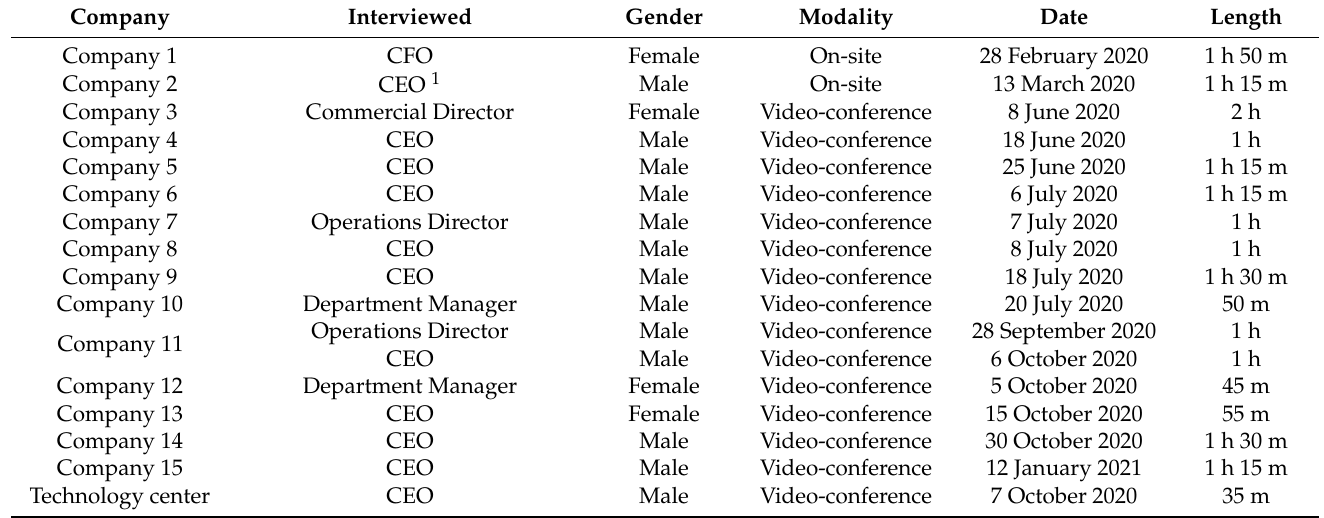
Table 1. Characteristics of the